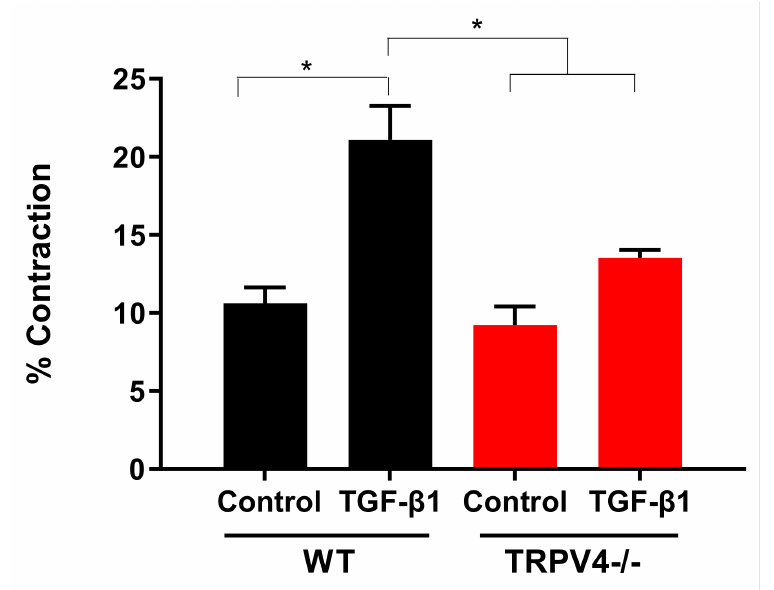
Figure 2. Contraction of primary murine lung fibroblasts (PMLF) in a gel matrix assay (modified from the Doctoral thesis of Jonas Weber (Ludwig-Maximilians-Universität (LMU)-Munich 2020, see http://edoc.ub.uni-muenchen.de/26578/). PMLFs from wild-type (WT) and TRPV4-deficient (TRPV4-/-) mice were seeded in collagen matrices in 6-well plates and transforming growth factor β (TGF- β 1) (2 ng/mL, TGF- β 1) or solvent (control) was added before release from the well edges (as described in Reference [93]). Diameters of matrices before and after adding TGF- β 1/solvent were measured and percent (%) contraction was quantified by calculating differences. Data are shown as means with standard errors of the mean (SEM) of three independent cell isolations (described in Reference [93]). * indicates a p -value of